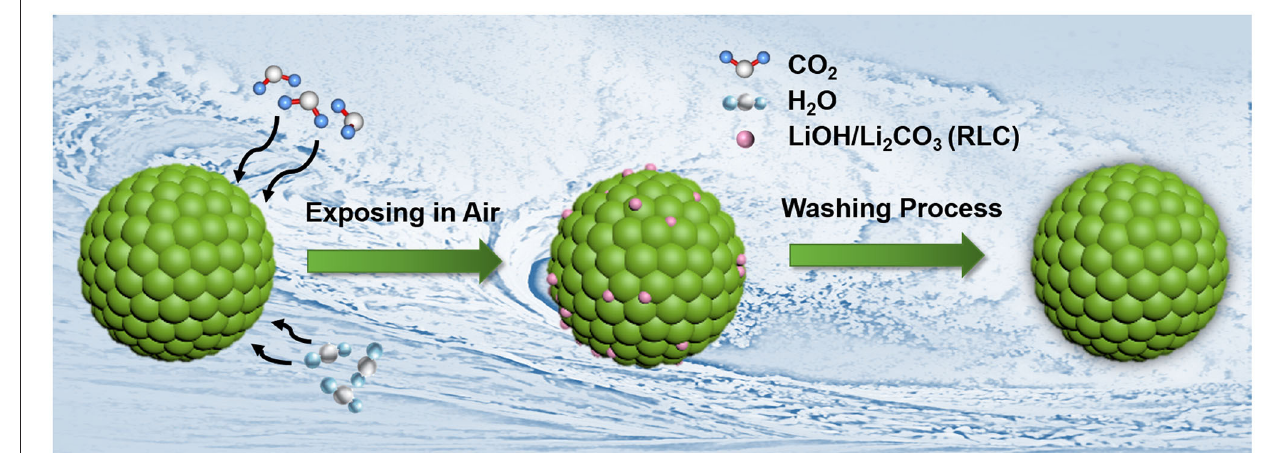
FIGURE 1 | The schematic diagrams for the washing process of LiNi 0.90 Co 0.06 Mn 0.04 O 2